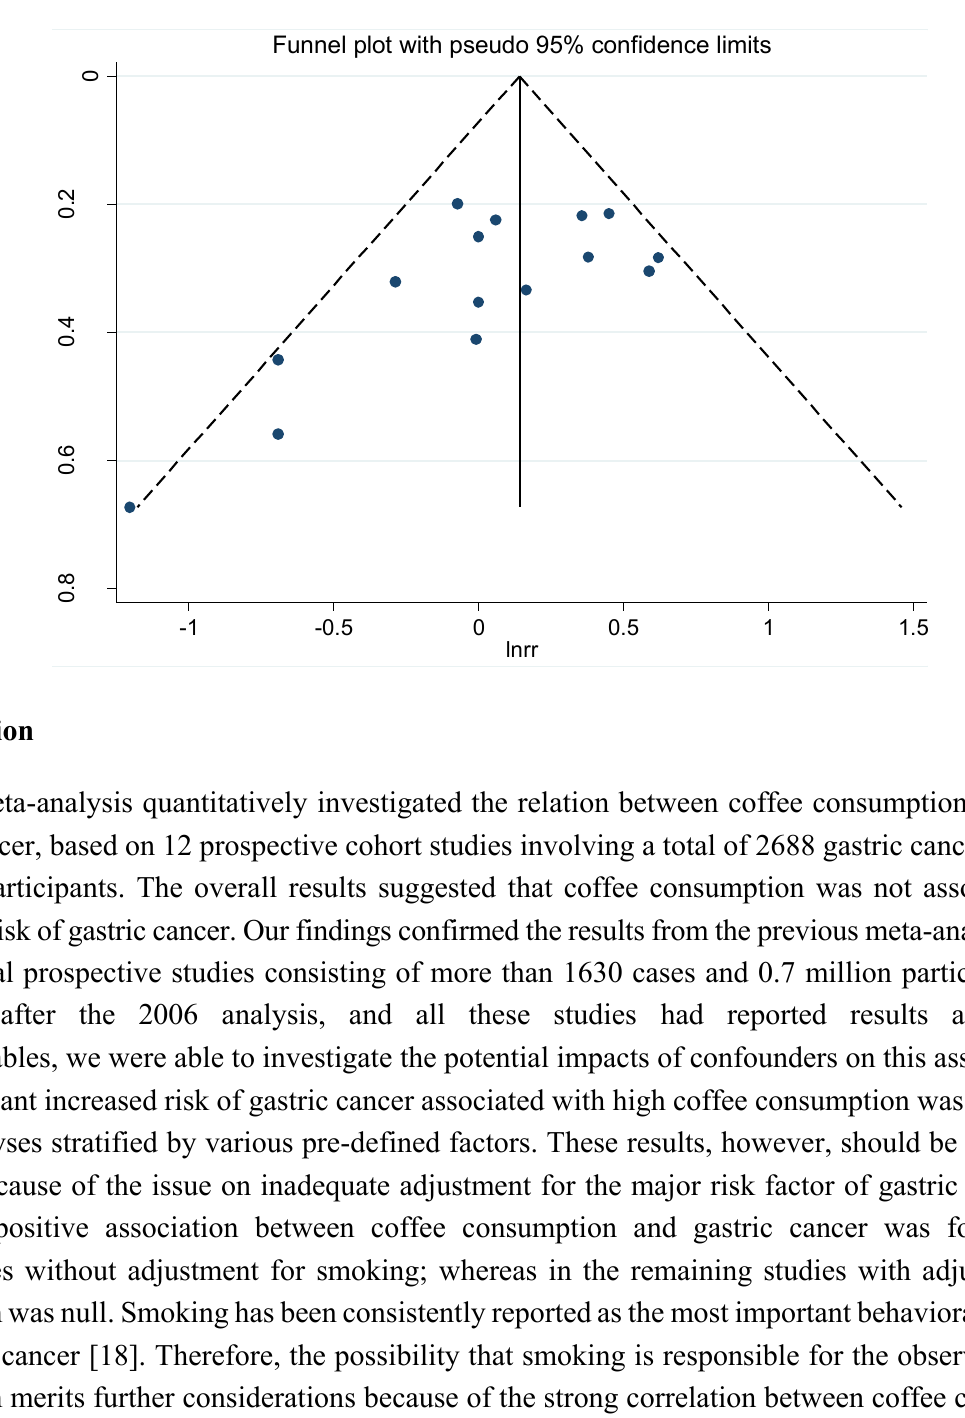
Figure 3. Begg’s funnel plot with pseudo-95% confidence limits for the RR of gastric cancer and coffee consumption (highest compared with lowest category of